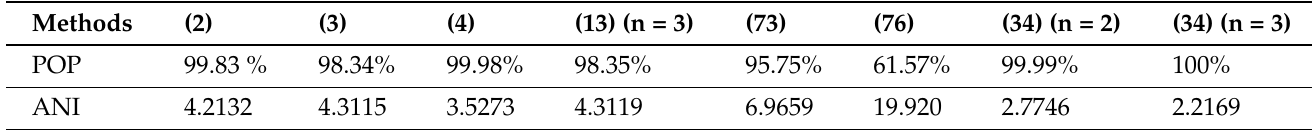
Table 4. Numerical results of different methods for z 5 − 1 = 0.